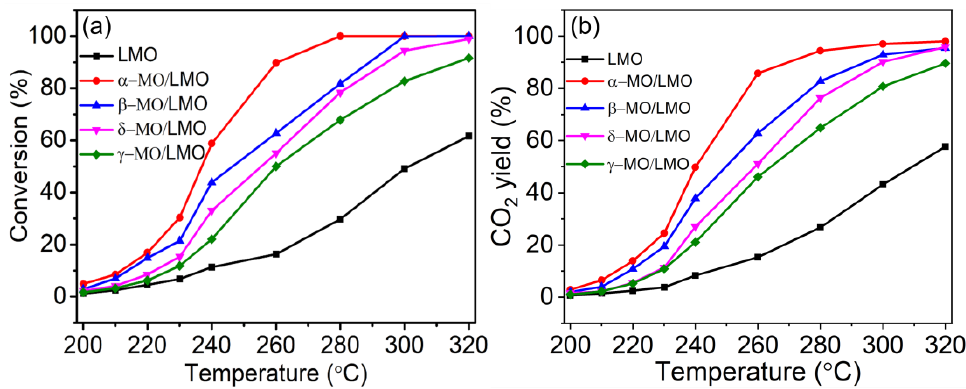
Figure 3. ( a ) Toluene conversion vs. temperature and ( b ) CO 2 yield over LMO, α -MO/LMO, β - MO/LMO, δ -MO/LMO, and γ -MO/LMO. Table 1. Catalytic performance for toluene oxidation over various catalysts. Samples